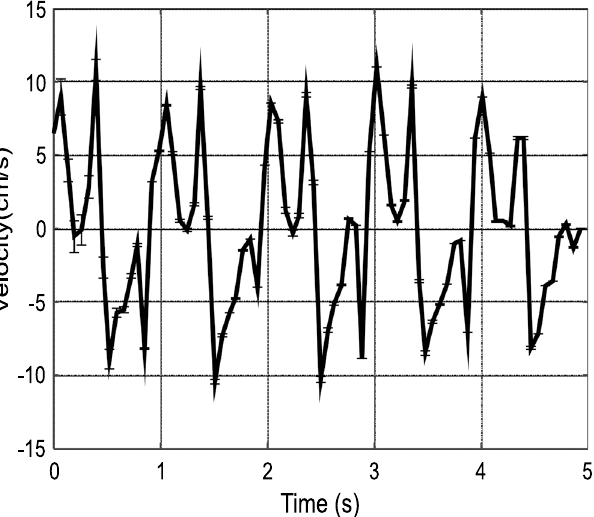
Figure 6. Tissue velocity values calculated from the vector length and interframe time and the standard deviation error bars for each